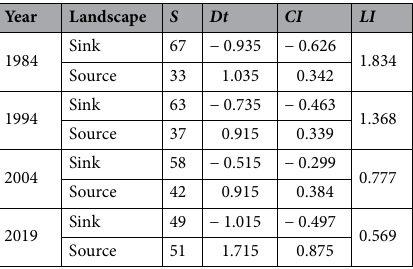
Table 3. Variations in LST of the source and sink with their landscape index over Akure.